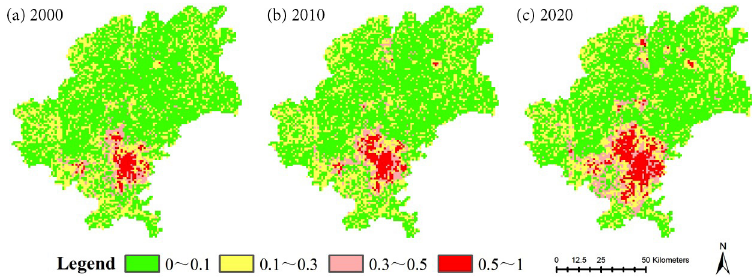
Figure 8. Spatial pattern of the human activity intensity in Guiyang